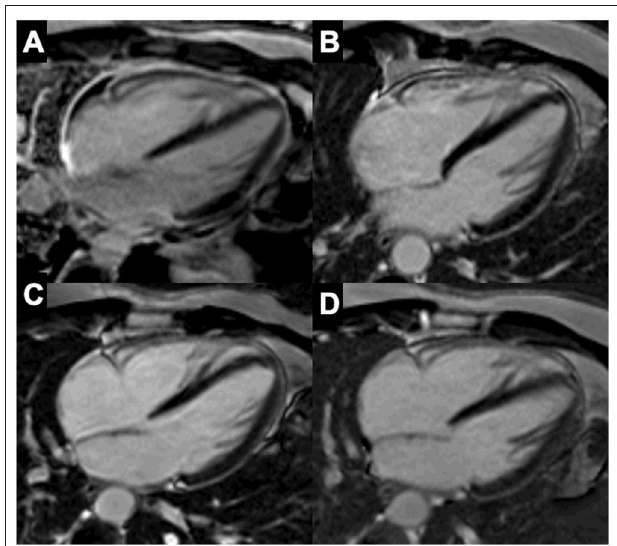
FIGURE 8 | Representative patient with pericarditis and resolution of the pericardial inflammation on sequential CMRI scans. Four-chamber late gadolinium enhancement (LGE) PSIR cardiac MRI images of a 35-year-old male patient who presented with recurrent idiopathic pericarditis under NSAIDs and colchicine. (A) At presentation, there was diffuse pericardial thickening and LGE, and presence of pericardial effusion. High-dose corticosteroids (prednisolone 40mg once daily) with taper schedule and azathioprine were initiated. (B) Re-evaluation after 3 months showed regression of pericardial LGE and disappearance of pericardial effusion. This allowed to further decrease the dose of steroids. (C) Follow-up cardiac MRI 5-months later showed near resolution of pericardial LGE. A low dose of steroids (prednisolone 4mg once daily) was maintained. (D) Control after 1 year showed a normal pericardium without LGE. Image courtesy of Bernard Paelinck (Antwerp University